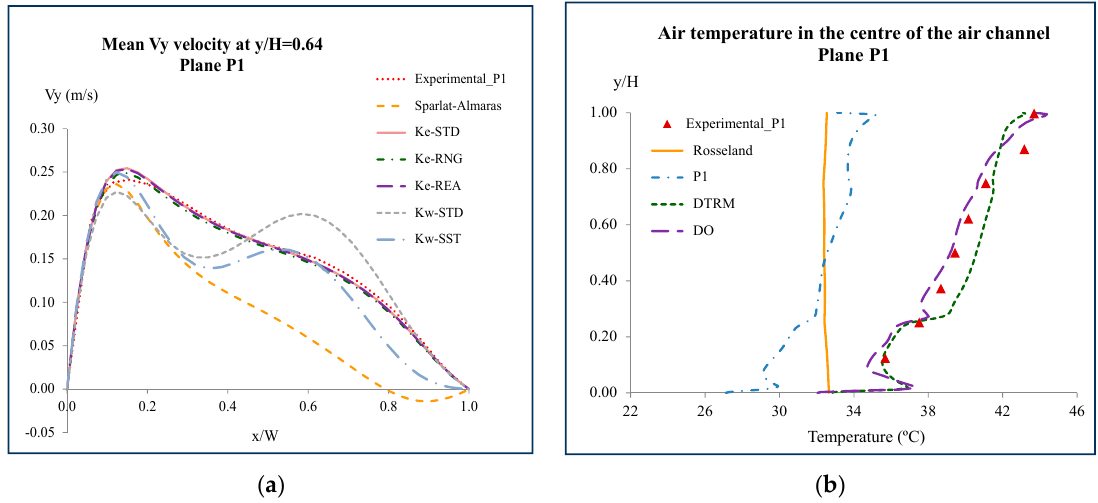
Figure 9. Vy velocity component for turbulence models ( a ) and temperature distribution inside the air cavity for radiation models ( b ). Ra = 1.0 × 10 9 conditions.